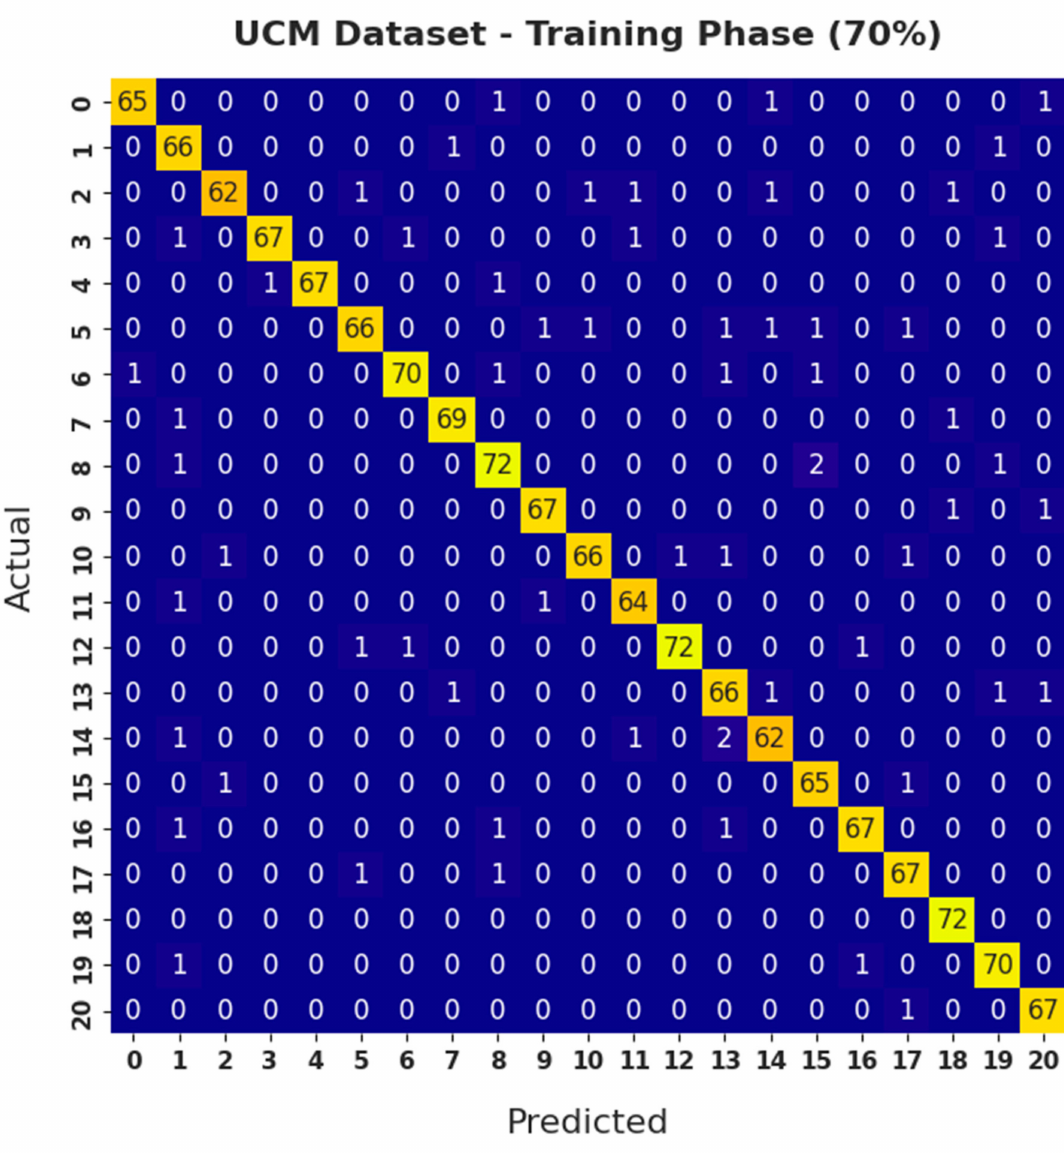
Figure 4. Confusion matrix of SIDTLD-AIC technique on 70% of UCM datasets as training